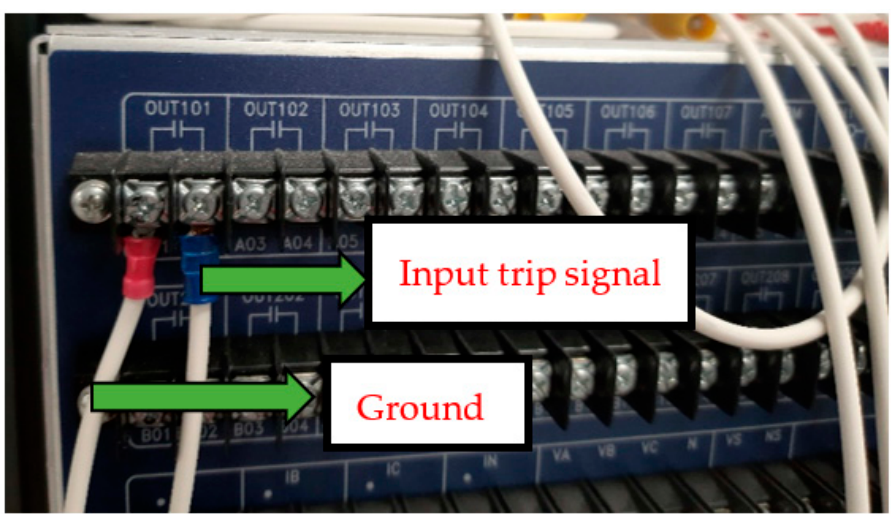
Figure 17. Connection on relay back panel with digital interface panel of RTDS.